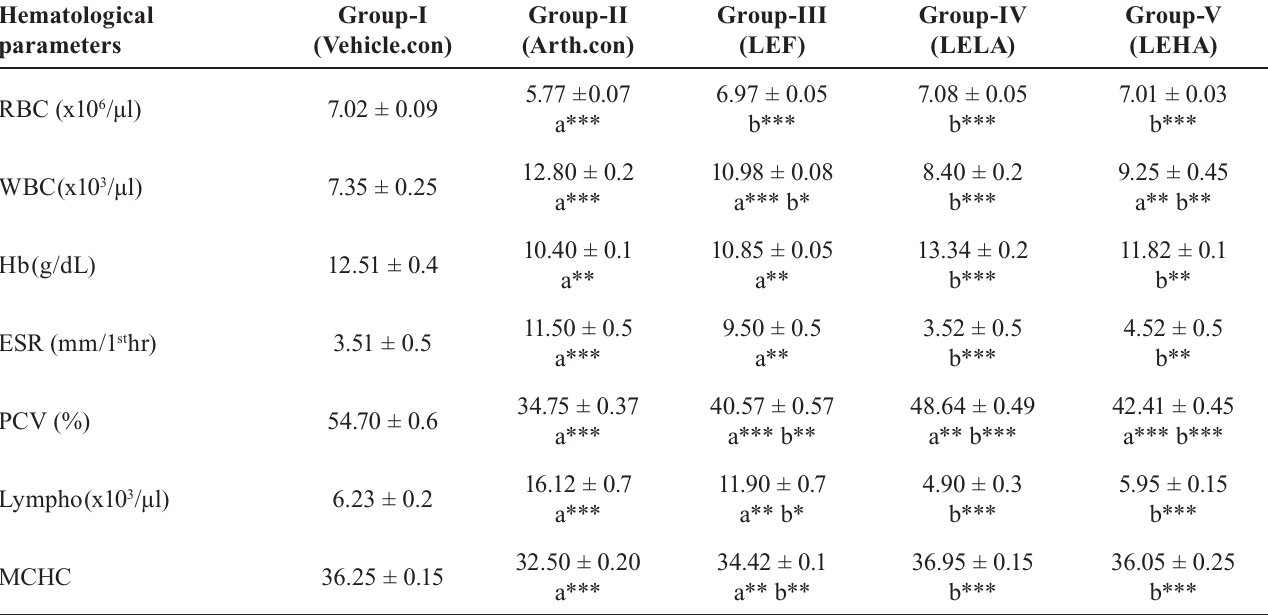
TABLE X- Ef fect of leflunomide and amitriptyline on Haematological parameters in FCA induced Arthritic rats